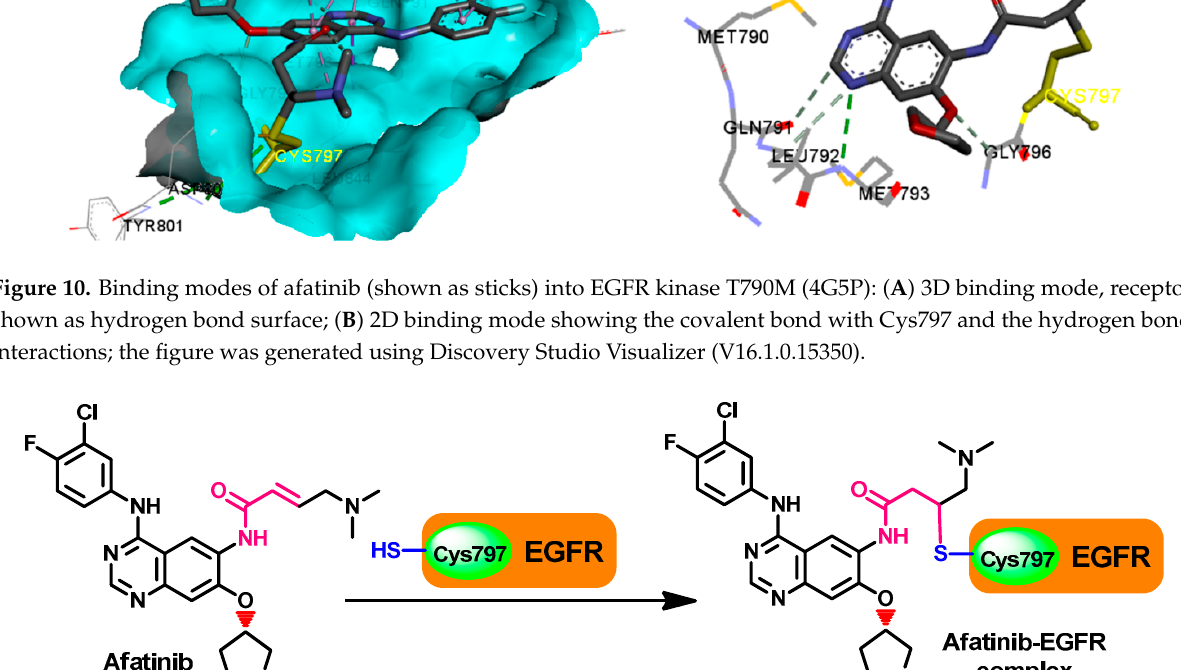
Figure 11. Mechanism of the irreversible inhibition of EGFR by afatinib.